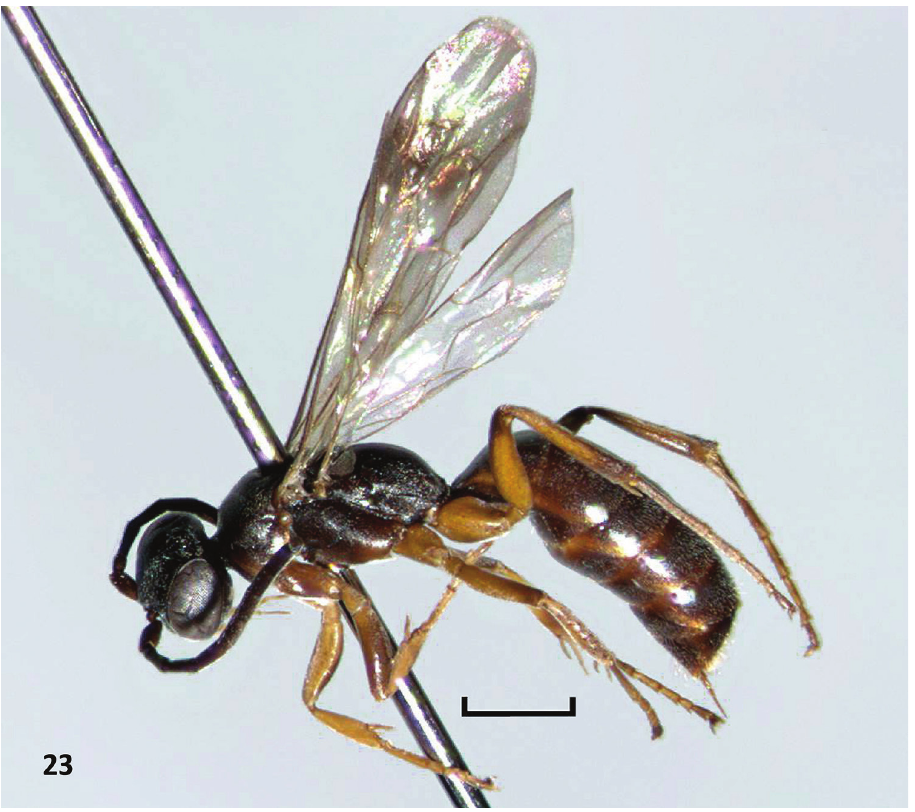
Figure 23. Nipponodipogon shimizui Loktionov, Lelej & Xu, sp. n., female, holotype, habitus, lateral view. Scale bars 1